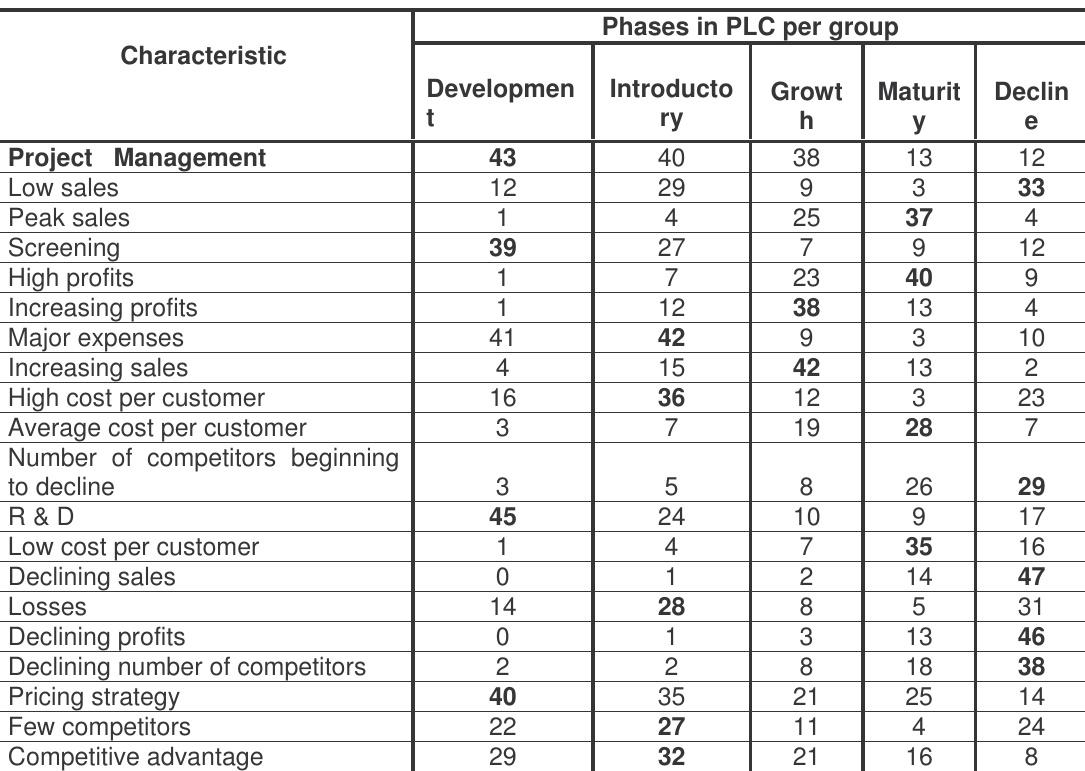
Frequency distribution of the